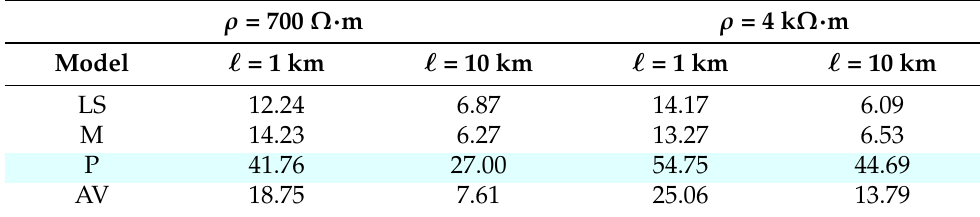
Table 9. (cid:101) ( % ) for the FD soil models (phases 2 and 3).